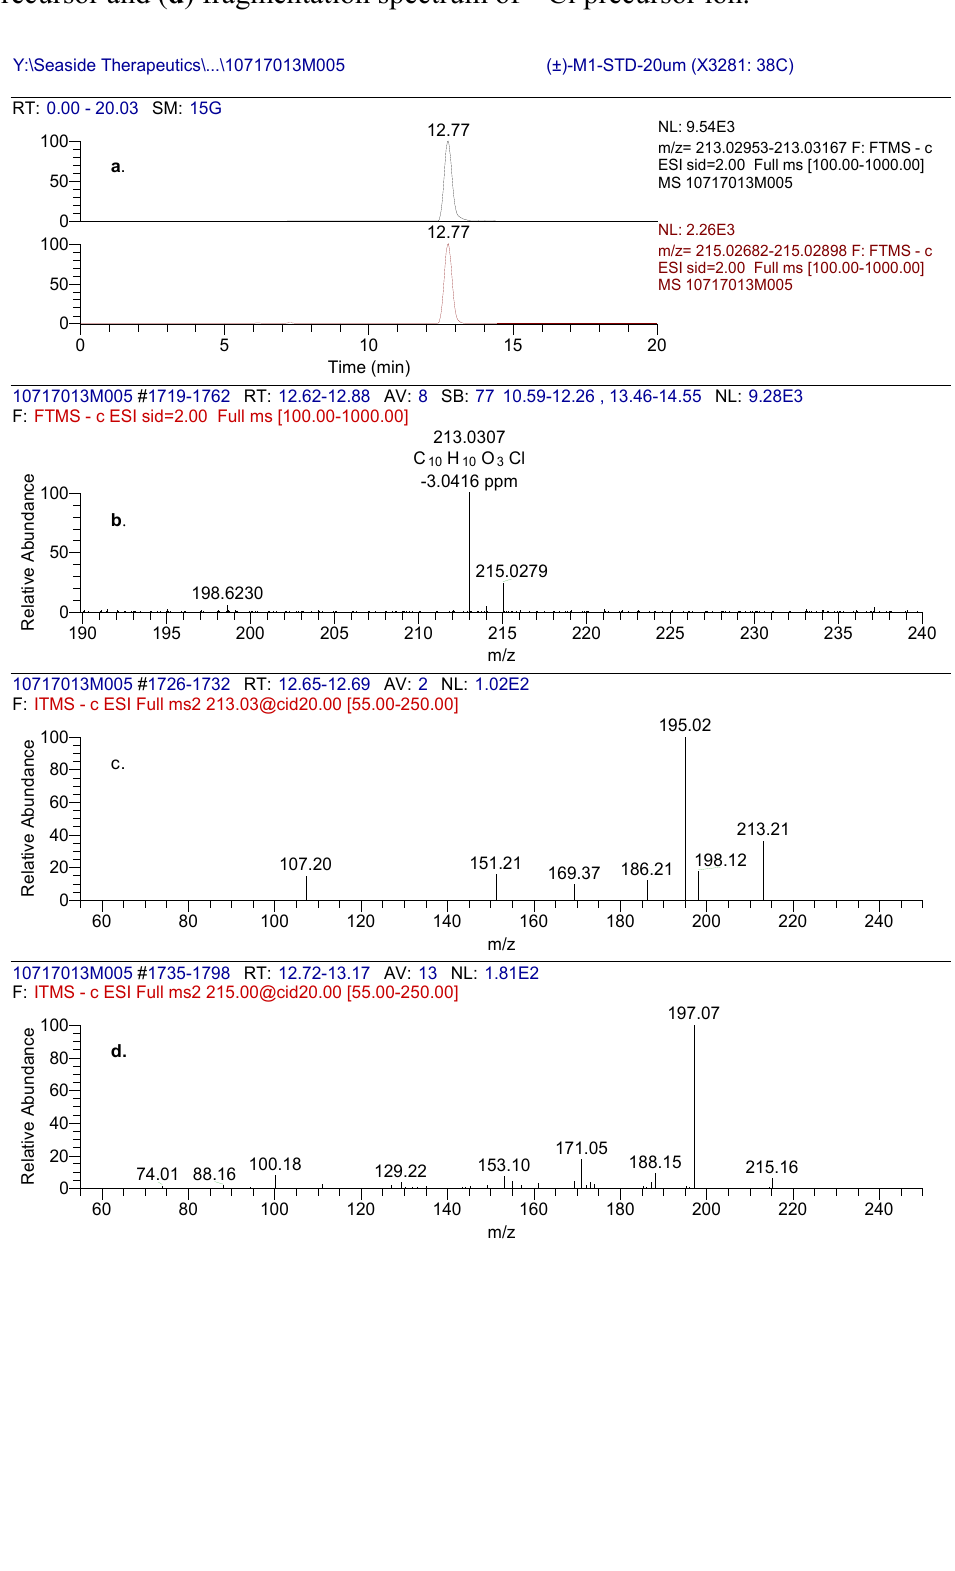
Figure 5. ( a ) High resolution extracted ion chromatogram of (±)-3-(4-chlorophenyl)-4- hydroxybutyric acid reference standard ( b ) Full scan of the precursor ion displaying a characteristic pattern of a compound containing chlorine ( c ) Fragmentation spectrum of 35 Cl precursor and ( d ) fragmentation spectrum of 37 Cl precursor